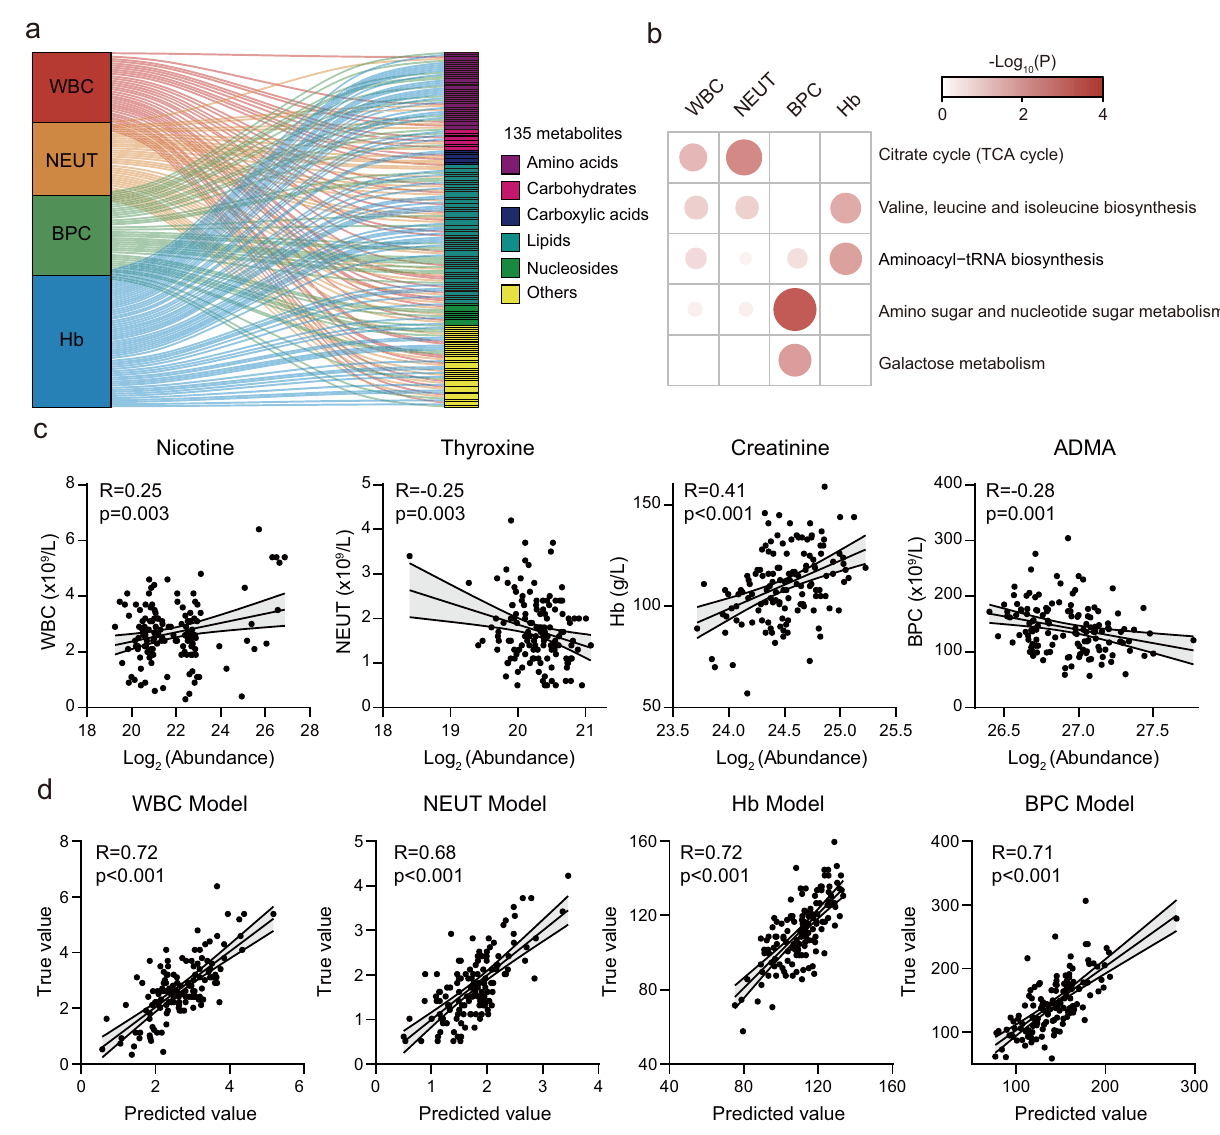
Fig.3|Pre-therapeuticmetabolictraitspredictthenCRTinducedhematologic toxicities. a Signi fi cant correlations between pre-therapeutic serum metabolites ( n =135) and cell counts that indicate hematologic toxicity (Pearson correlation; two-sided Student ’ s t test P <0.05). WBC, white blood cells; NEUT, neutrophils; BPC, blood platelet cells; Hb, hemoglobin. b Pathway enrichment analyses of hematologic toxicity associated metabolites (Hypergeometric test; P <0.05). c Four metabolite examples and their correlations with hematologic toxicities.